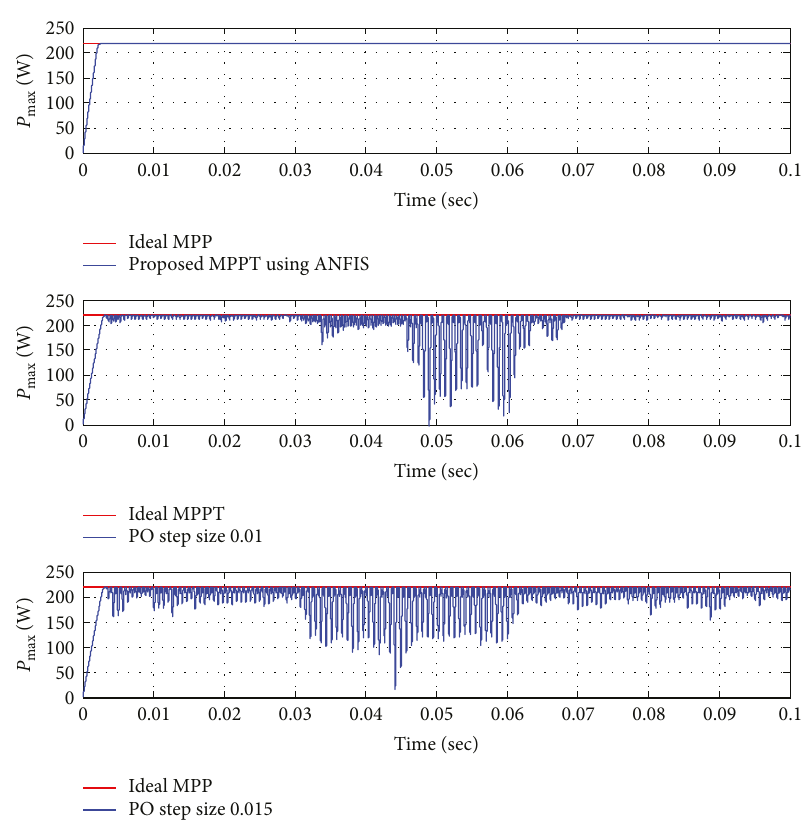
Figure 19: MPP tracking performance under load changes.